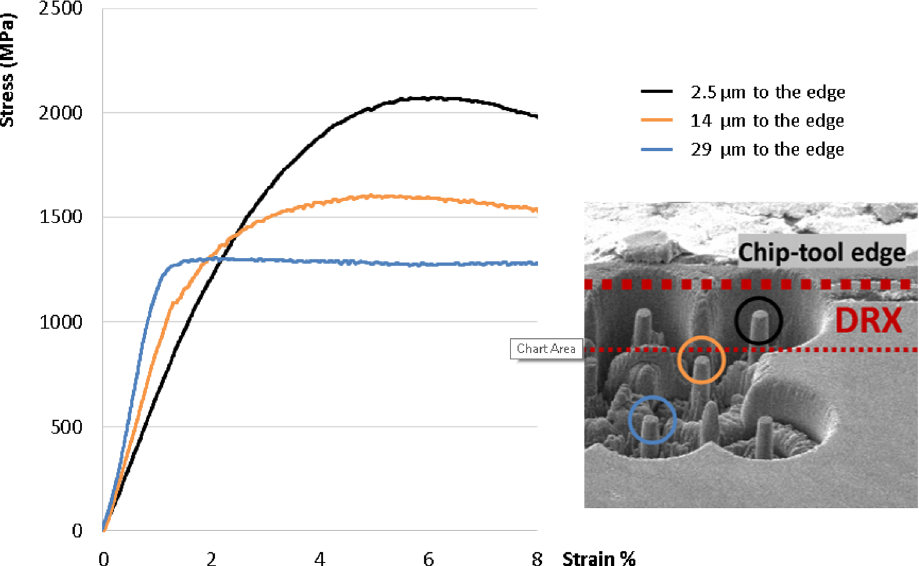
Figure 5. The graph shows the stress–strain plot for 2 µm diameter pillars milled at 2.5, 14 and 29 µm from the chip edge.